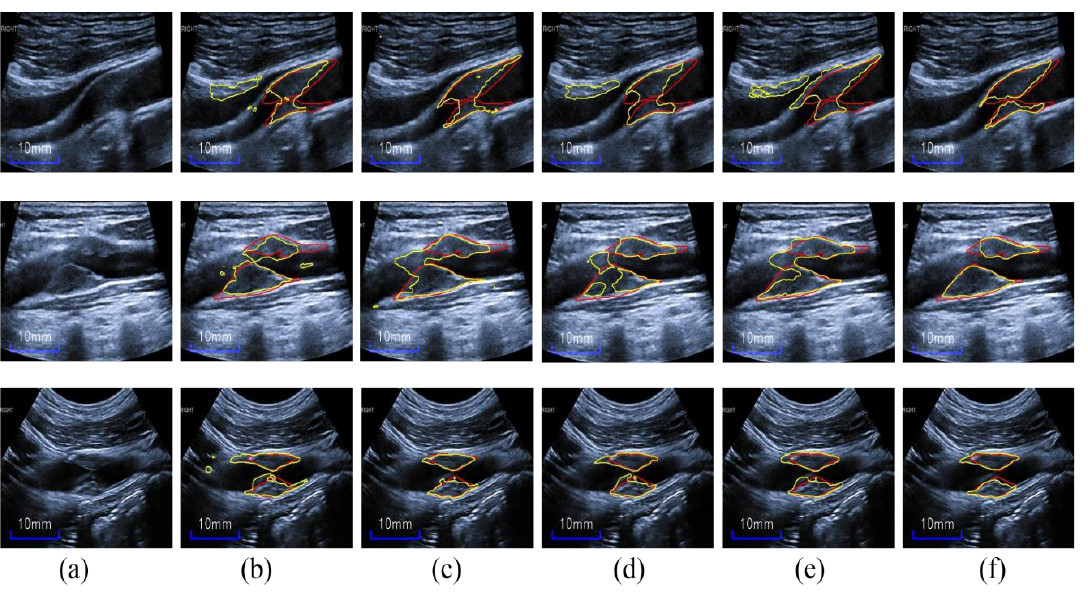
Figure 9. Transfer learning effect: ( a ) input images, ( b ) RU-CBV, ( c ) RU-CBV-T, ( d ) U-Net, ( e ) M-Net, and ( f ) HRU-CBV-T (proposed). The red and yellow outlines superimposed on the input images denote the labels and segmentation result contours.